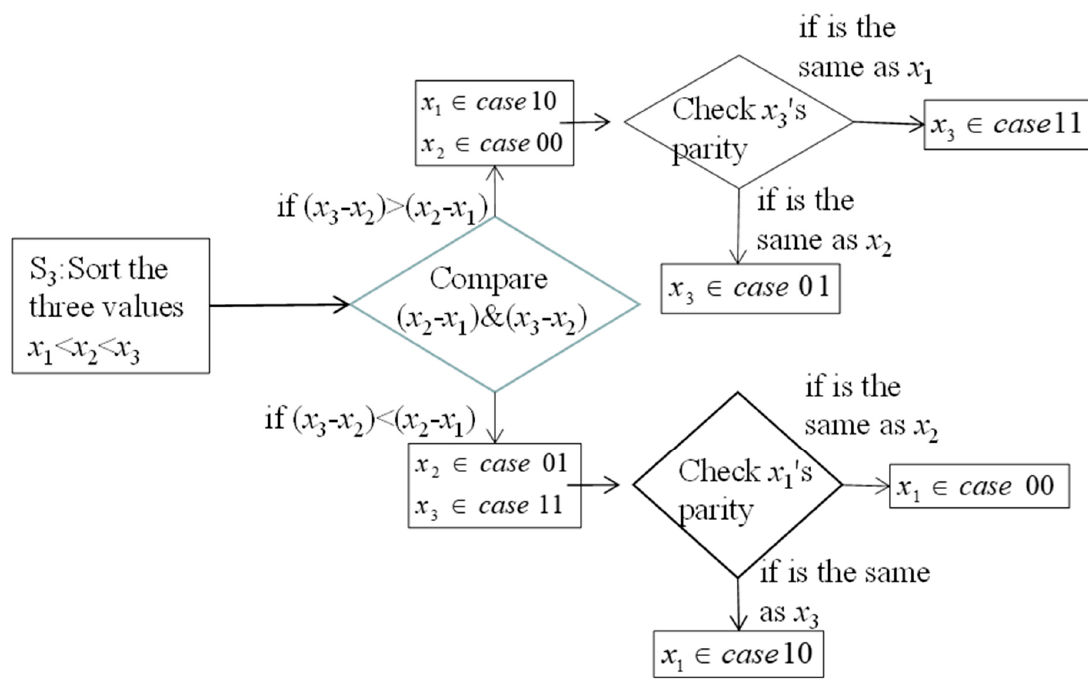
Figure 5. Flowchart of extraction phase when S = 3. Note: S indicates the number of different pixel values.